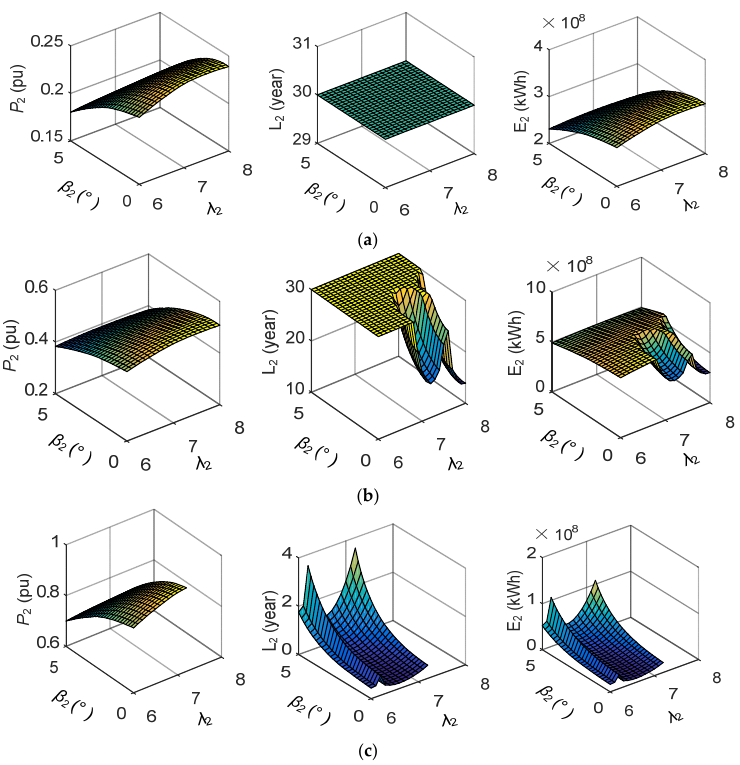
Figure 15. The active power, lifetime, and energy production in terms of the pitch angle and tip speed ratio at the wind speed of: ( a ) 7 m/s; ( b ) 9 m/s; ( c ) 11 m/s.